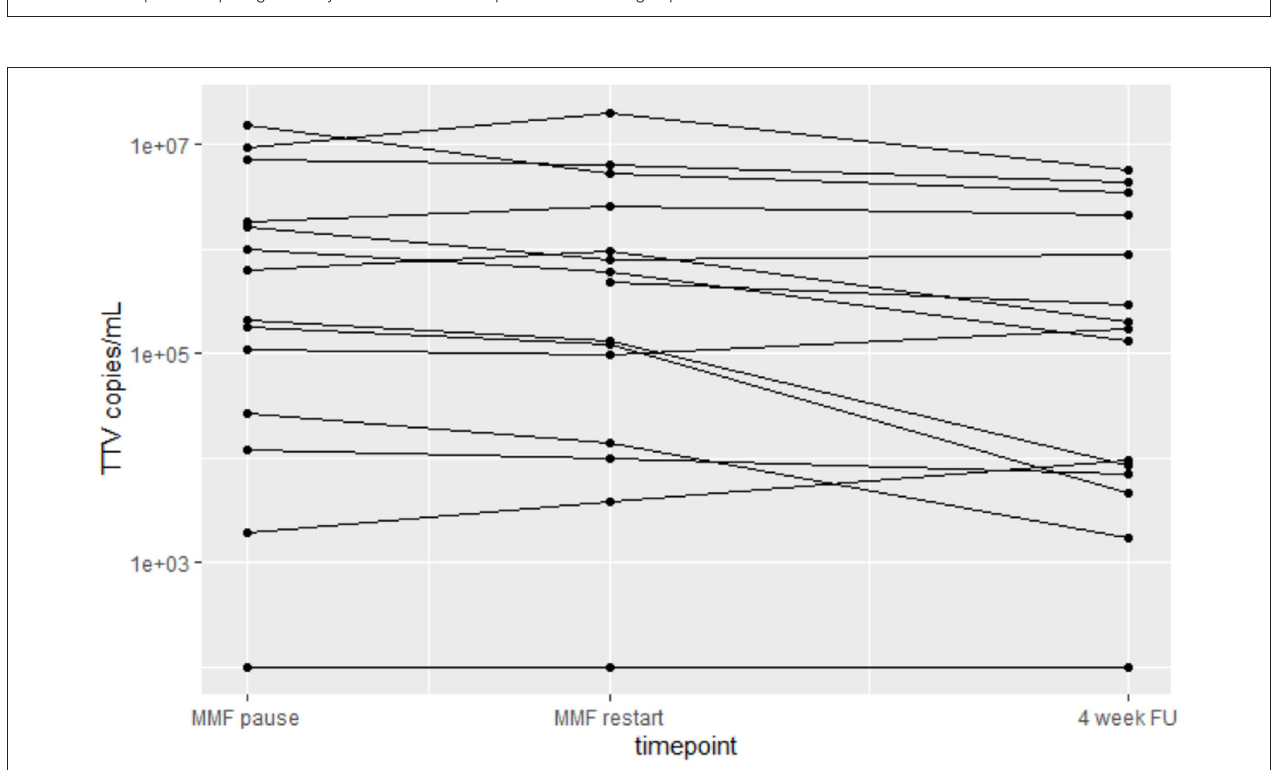
FIGURE 3 | Changes in TTV load in patients at baseline, after 2 weeks of MPA pause and at the 4-week follow-up after vaccination.